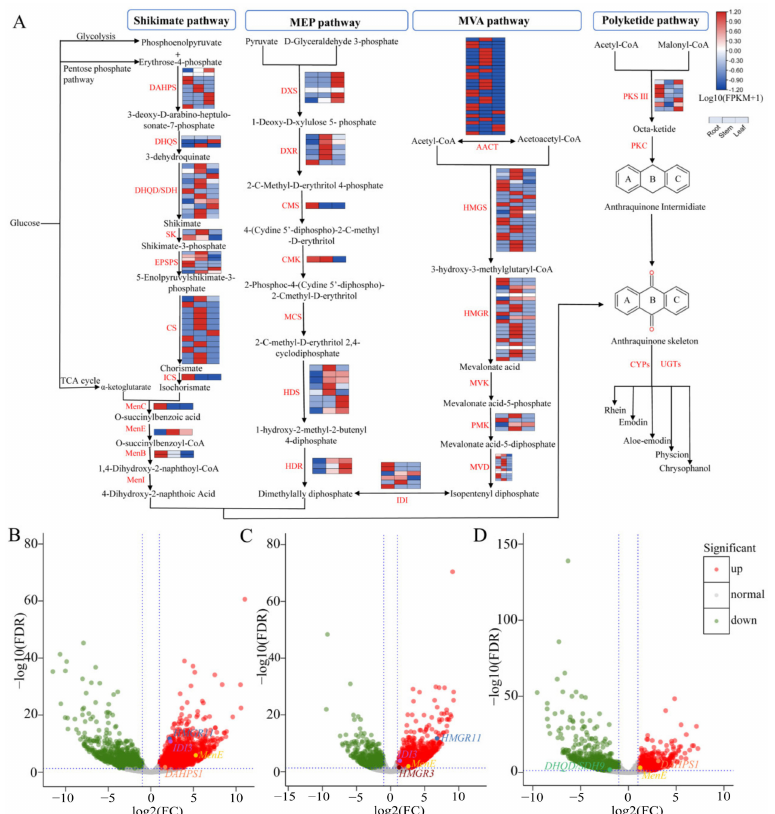
Figure 4. Genes involved in anthraquinone biosynthesis. ( A ) Simplified representation of biosyn- thetic pathway and expression pattern of unigenes involved in the biosynthesis of anthraquinones. The expression values for each enzyme gene are indicated in color on the log 10 (FPKM + 1) scale for 3 tissues: roots, stems, and leaves. DAHPS: 3-Deoxy-7-phosphoheptulonate synthase; EPSPs: 3-Phosphoshikimate 1-carboxyvinyltransferase; DHQS: 3-Dehydroquinate synthase; DHQD/SDH: 3-Dehydroquinate dehydratase/shikimate dehydrogenase; SK: Shikimate kinase; CS: Choris- mate synthase; MenE: o-Succinylbenzoate-CoA ligase; ICS: Isochorismate synthase; MenC: o- Succinylbenzoate synthase; MenB: 1,4-Dihydroxy-2-naphthoyl-CoA synthase; DXS: 1-Deoxy-D- xylulose-5-phosphate synthase; HDR: 4-Hydroxy-3-methylbut-2-en-1-yl diphosphate reductase; DXR: 1-Deoxy-D-xylulose-5-phosphate reductoisomerase; CMS: 2-C-Methyl-D-erythritol 4-phosphate